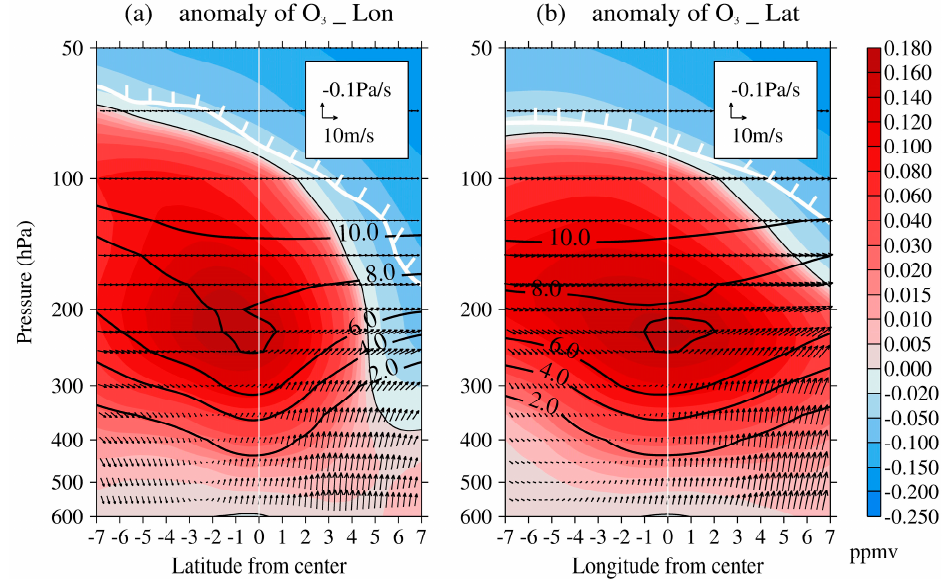
Figure 4. Meridional ( a ) and zonal ( b ) cross sections of the ozone anomalies along the center of COLs at the time of their maximum intensity. Potential vorticity (black contour, unit: PVU) and wind (vector, the synthesis of vertical and horizontal wind component) is superimposed on the figure. The regions “downhill” of the white thick contour did not meet the 95% confidence level following a t- test.